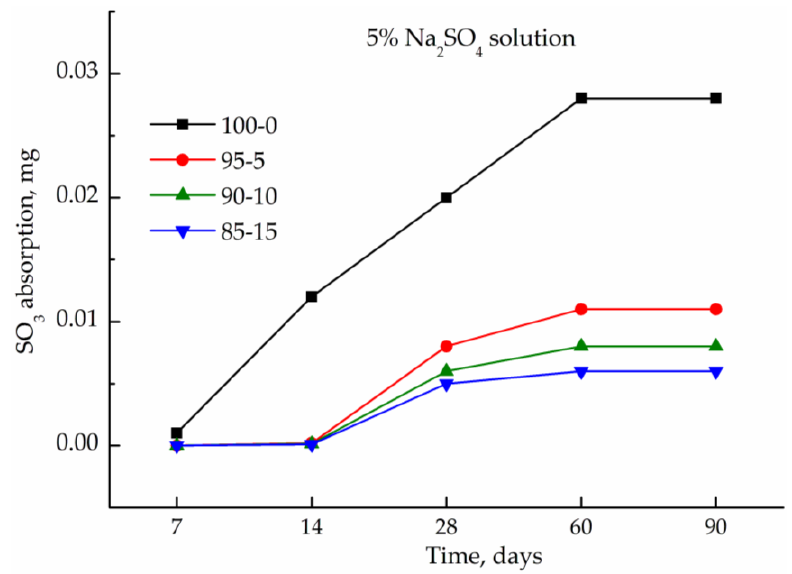
Figure 12. Kinetics of the sulphate ions absorption by the mixed cement samples from 5% Na 2 SO 4 solution.